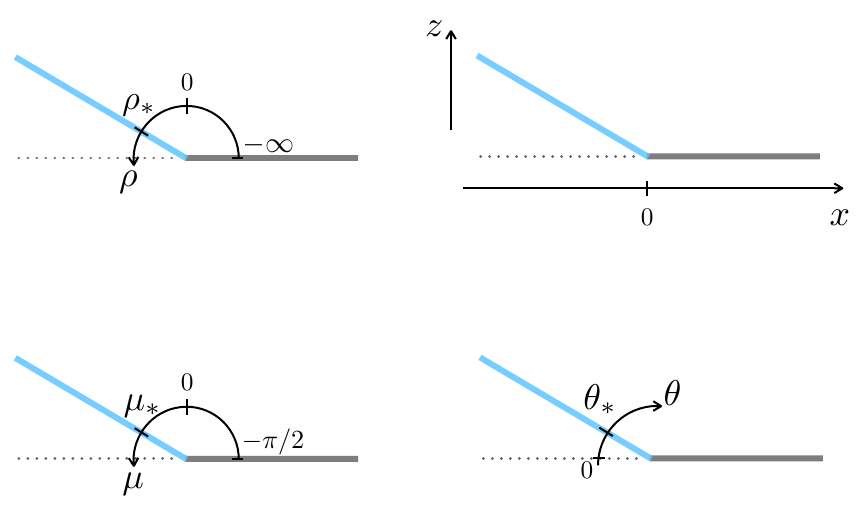
Figure 7 . Coordinates describing the Poincaré patch shown in a time slice of AdS 3 . The asymptotic boundary Σ is shown in grey and the brane Q is shown in